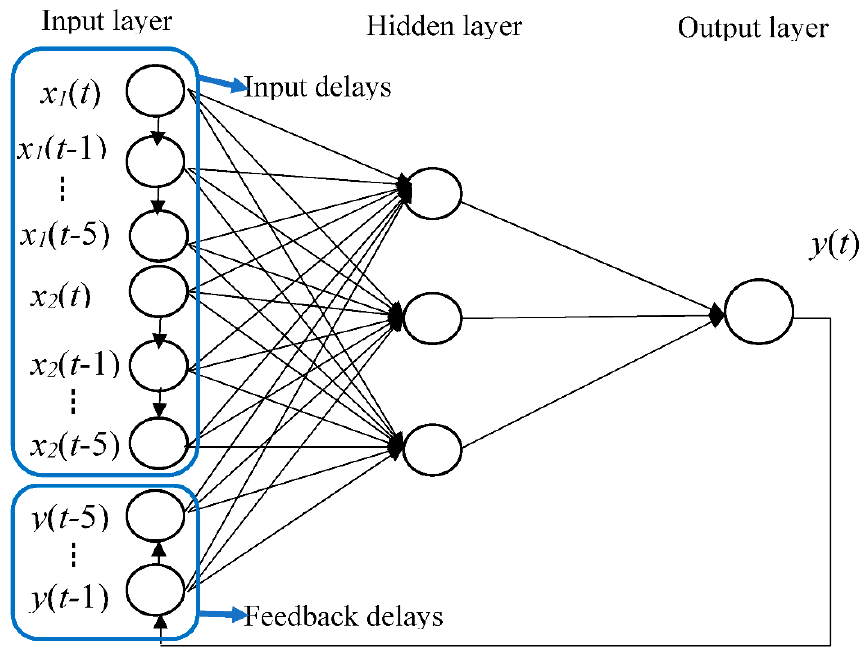
Figure 2. The structure of the NARX model.